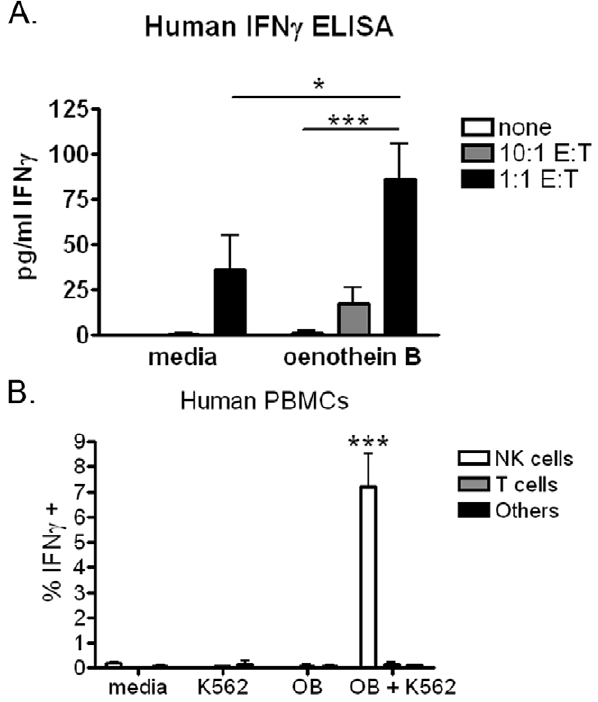
Figure 7. Priming of human NK cells to K562 cells by oenothein B. (A) Human PBMCs (10 5 cells/well) were treated with 20 m g/ml oenothein B or X-VIVO medium alone for approximately 24 hrs. Cells were then washed and co-cultured with or without K562 cells at effector:target (E:T) ratios of 10:1 and 1:1 for approximately 42 hrs. After incubation, soluble IFN c levels were measured by ELISA. The data represent pooled results from three donors and are expressed as mean + / 2 SEM. Samples were analyzed in duplicate. Statistical significance was measured by Two-way ANOVA with Bonferroni post-test. (B) Human PBMCs (10 5 cells/well) were treated with 20 m g/ml oenothein B or X-VIVO medium alone for approximately 24 hrs. Cells were then washed and co-cultured with or without K562 cells at an effector:target (E:T) ratio of 1:1 for approximately 18 hrs. After incubation, brefeldin A was added to the culture for 6 hrs. IFN c expression by NK cells (CD3 2 / CD56 + ), T cells (CD3 + ), and others (CD3 2 /CD56-) was then measured by intracellular flow cytometry. The data represent pooled results from two donors and are expressed as mean + / 2 SEM. Samples were analyzed in duplicate. Statistical significance was measured by One-way ANOVA with Bonferroni post-test. *p , 0.05, **p , 0.01, ***p , 0.001.